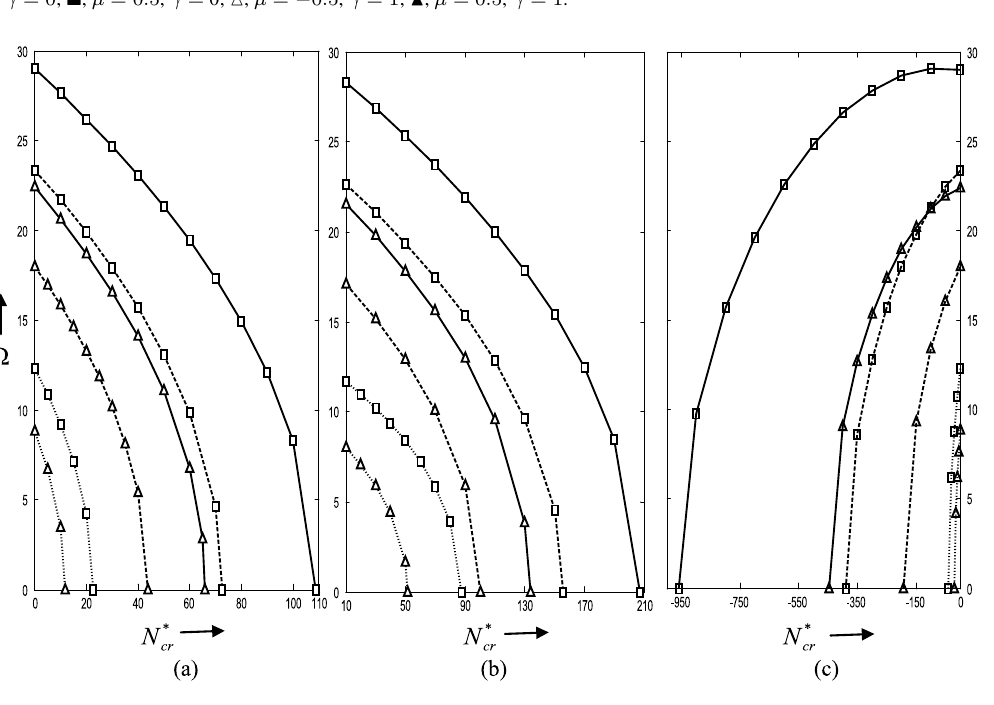
Fig. 8. Frequency parameter Ω for (a) first mode (b) second mode (c) third mode. _____, C-C; - - - - -, C-S; ......, C-F; N ∗ 0 = 30, a/b = 1 ; (cid:3) , μ = − 0 . 5 , γ = 0 ; (cid:5) , μ = 0 . 5 , γ = 0; (cid:4) , μ = − 0 . 5 , γ = 1 ; (cid:6) , μ = 0 . 5 , γ = 1 .